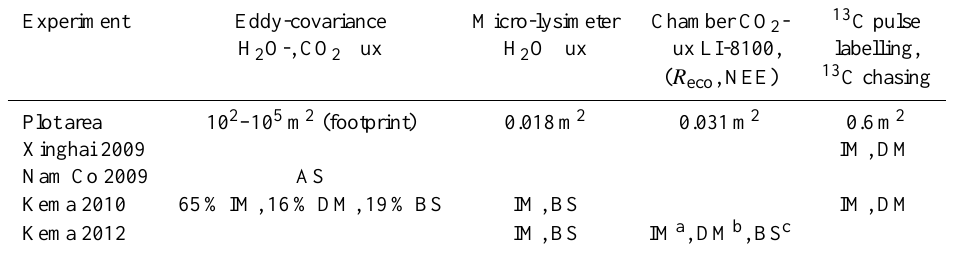
Table 5. Experimental setup during the different experiments, with the corresponding measuring technique and the degree of degradation, (intact root Mat: IM, degraded root Mat: DM, bare soil: BS, alpine steppe: AS).